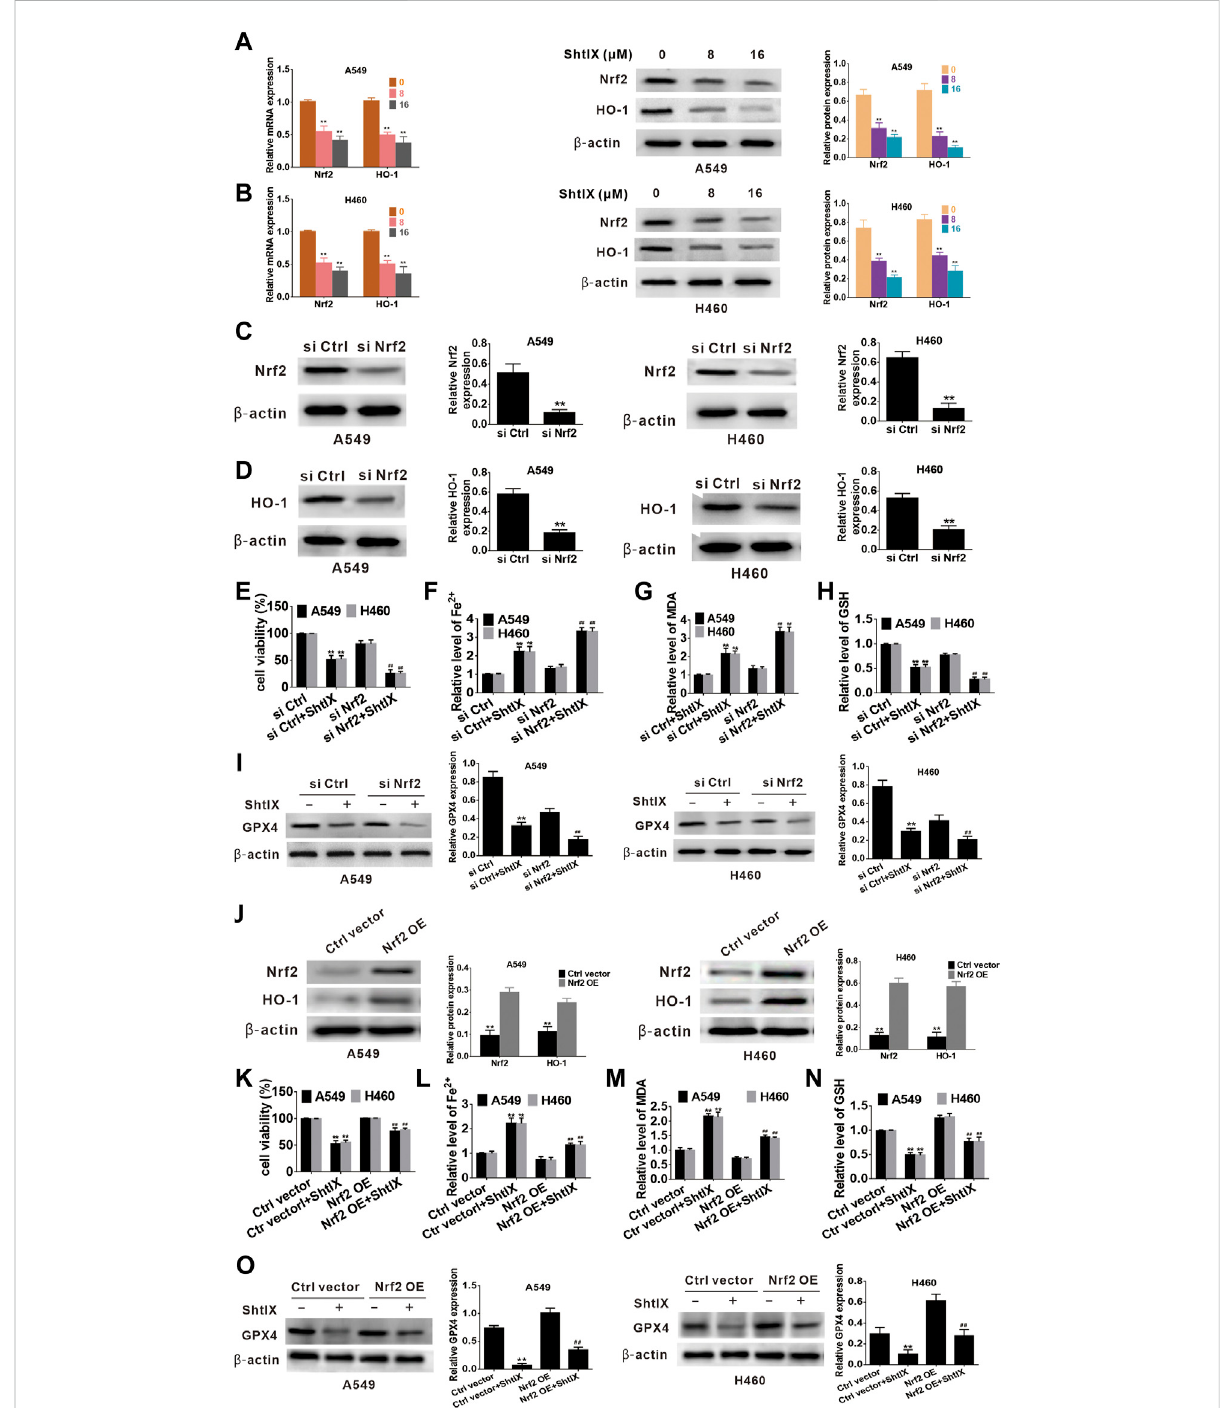
FIGURE 6 Nrf2/HO-1playsaroleinShtIX-inducedferroptosisinNSCLCcells. (A,B) CellstreatedwithdifferentdoseofShtIXfor24 h,thelevelsofNrf2and HO-1 were measured using RT-qPCR assay and western blot. (C) A549 and H460 cells were transfected with Nrf2 siRNA and control siRNA, and the ef fi ciency of the knockdown Nrf2 was detected by western blot. (D) HO-1 expression in Nrf2 knockdown cells was assessed by western blot. (E – I) Cells treated as (C) , cell viability and ferroptosis-related markers were determined. (J) Western blot analysis was performed to detect the expression levels of Nrf2 and HO-1 protein following transfection with overexpression plasmids. (K – O) After cells were transfected with overexpression plasmid, cell viability and ferroptosis-related markers were evaluated. Data are expressed as mean ± SD of triplicate experiment.* p < 0.05, ** p < 0.01, # p < 0.05, ## p <